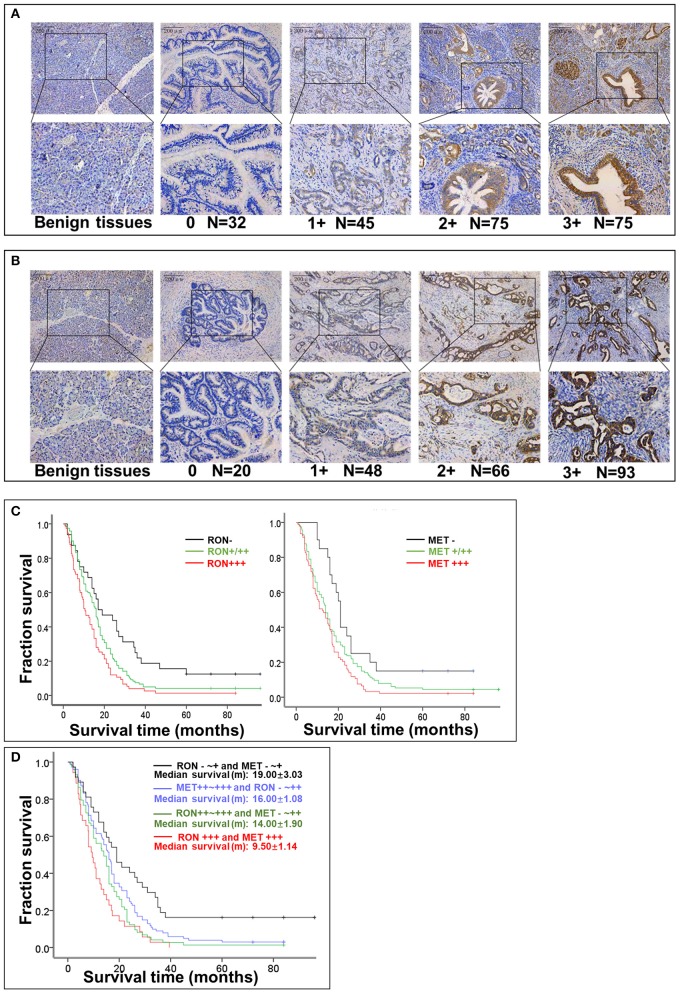
Relationship between RON and MET expression levels in pancreatic cancer tissue samples and OS. (A) RON expression level in benign tissues and pancreatic cancer tissues. Original magnification ×100 (all photomicrographs). (B) MET expression level in benign tissues and pancreatic cancer tissue. (C) Kaplan–Meier plots with log-rank test analysis of the relationship between RON or MET expression level and survival. (D) Relationship between RON and MET co-expression and survival.